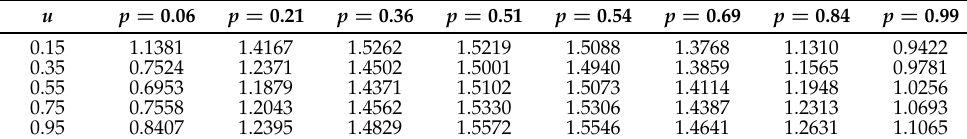
Table 4. The values of V ( u ;0.5 ) when λ 2 = 0, µ = 1, δ = 0.06, c = 0.4, α = 0.1.